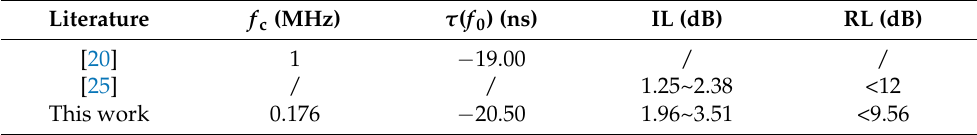
Table 7. Performance comparison between high-pass negative group delay and reported NGD